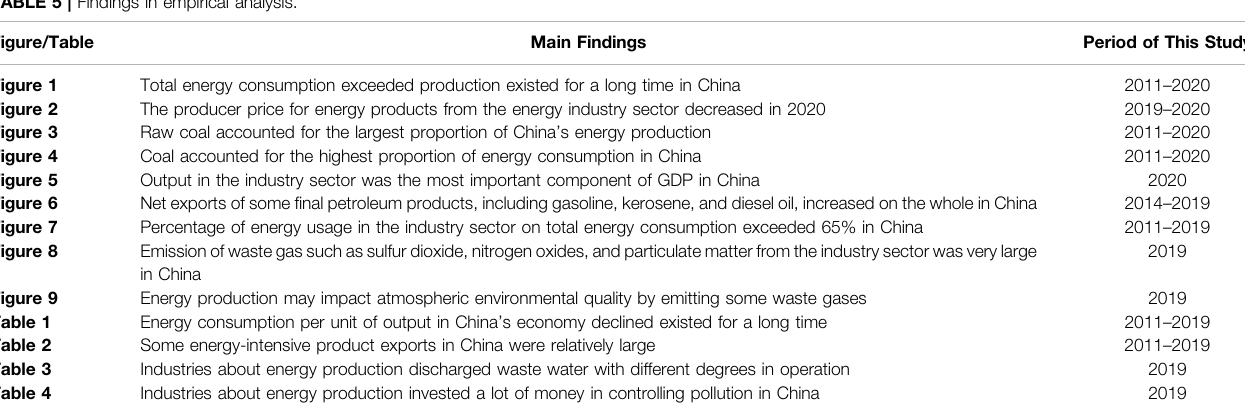
TABLE 5 | Findings in empirical analysis. Main Findings Period of This Study Figure 1 Total energy consumption exceeded production existed for a long time in China The producer price for energy products from the energy industry sector decreased in 2020 Raw coal accounted for the largest proportion of China ’ s energy production Coal accounted for the highest proportion of energy consumption in China Output in the industry sector was the most important component of GDP in China Net exports of some fi nal petroleum products, including gasoline, kerosene, and diesel oil, increased on the whole in China Percentage of energy usage in the industry sector on total energy consumption exceeded 65% in China Emission ofwastegassuch assulfur dioxide, nitrogen oxides,and particulatematterfromtheindustrysector wasverylarge in China Figure 9 Energy production may impact atmospheric environmental quality by emitting some waste gases Energy consumption per unit of output in China ’ s economy declined existed for a long time Some energy-intensive product exports in China were relatively large Industries about energy production discharged waste water with different degrees in operation Industries about energy production invested a lot of money in controlling pollution in China